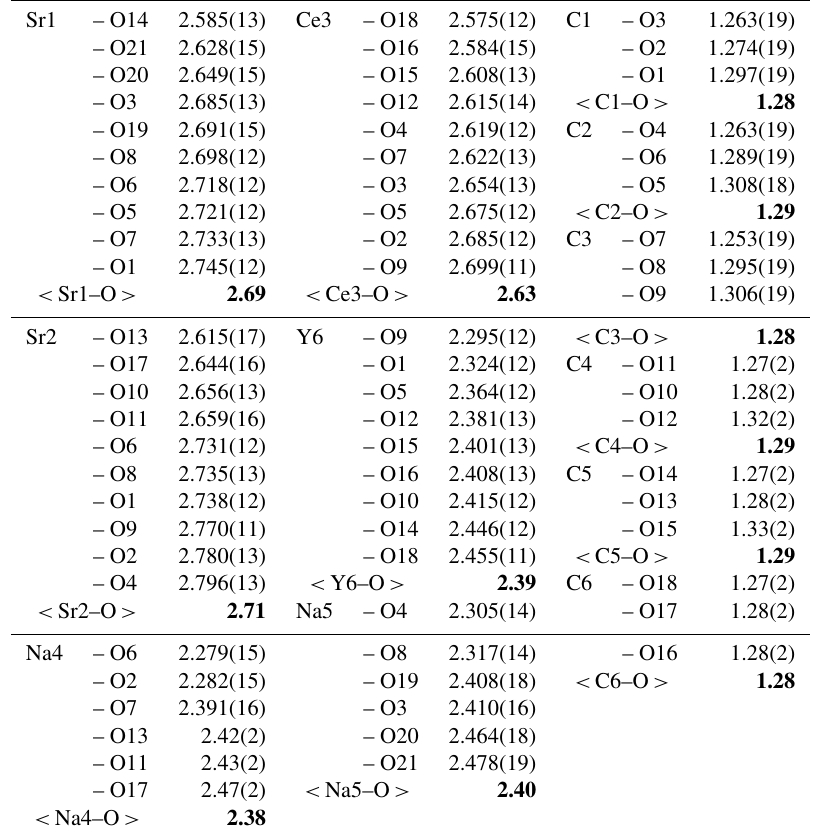
Table 5. Selected interatomic distances (Å) in the structure of alicewilsonite-(YCe). The average interatomic distances are given in